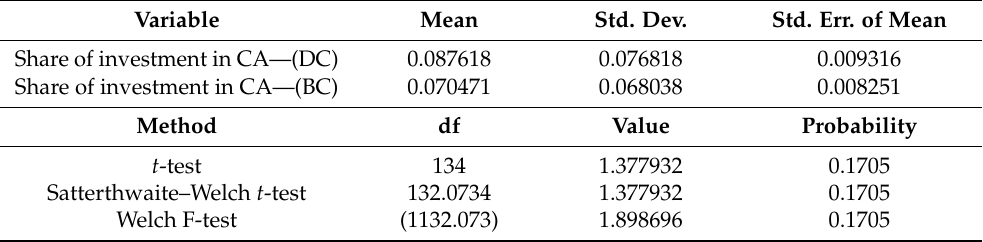
Table 15. The result of the share of short investment in current assets. Variable Mean Std. Dev. Std. Err. of Mean